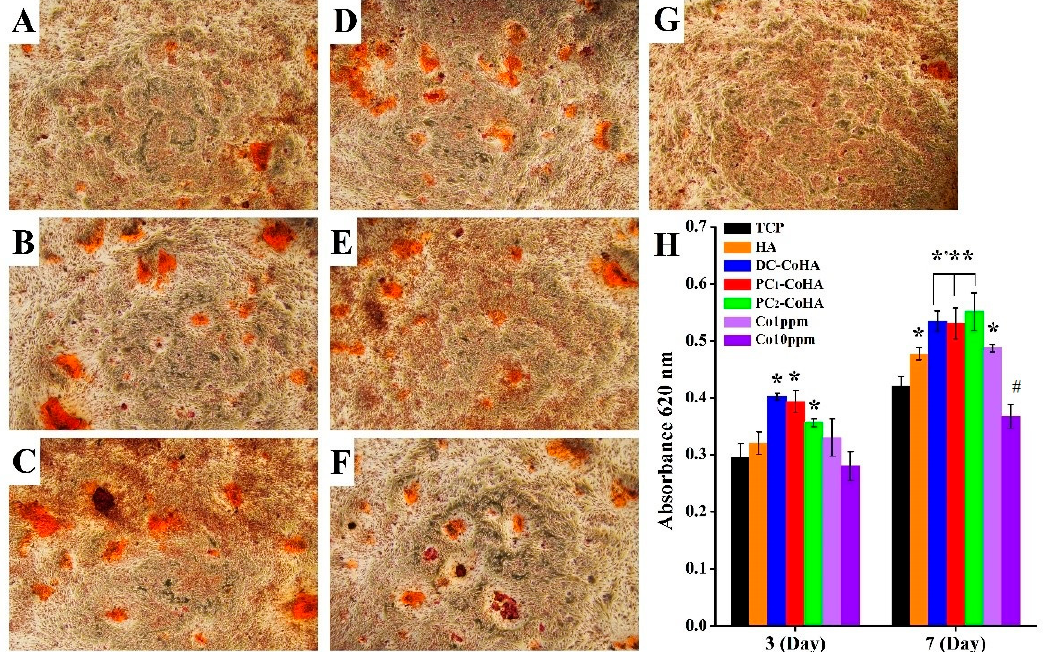
Figure 10. The degree of MG63 cells were cultured for 7 days with extracellular matrix mineralization determined by Alizarin Red S (Sigma) staining. ( A ) tissue culture plate (TCP), ( B ) HA, ( C ) DC-CoHA, ( D ) PC 1 -CoHA ( E ) PC 2 -CoHA, ( F ) Co1ppm and ( G ) Co10ppm. ( H ) Quantitative analysis of matrix deposition mineralization was performed at 3 and 7 days. *: Significantly higher than the control group (TCP) **: Significantly higher than HA and Co1ppm groups. #: Significantly lower than the control group ( p <